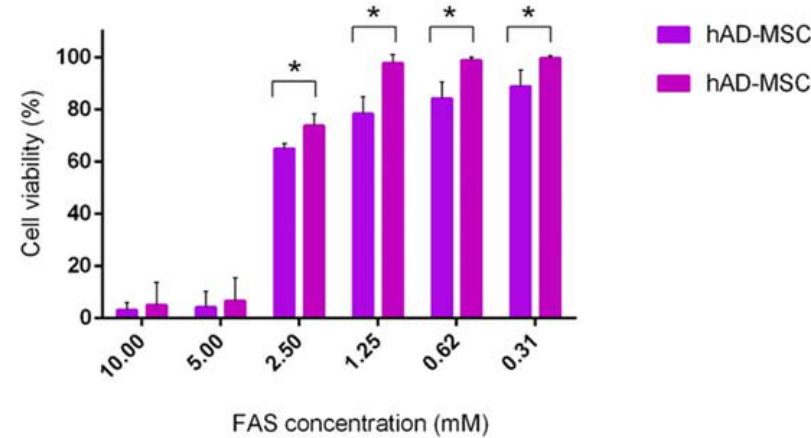
Figure 3. MTS assay evaluating the cytotoxicity of various concentrations of FAS in hAD-MSCs and hAD-MSCs-Mx. The data are shown as the mean + S.D. of three independent experiments; p -values were calculated using a one-tailed t-test, assuming unequal variances (* indicate p -values < 0.05). After incubation with 1–2 mM FAS, Prussian blue staining of hAD-MSCs-Mx cells showed accumulated iron deposits in the cytoplasm and nucleus. Interestingly, non- transduced cells did not demonstrate such patterns (Figure 4).